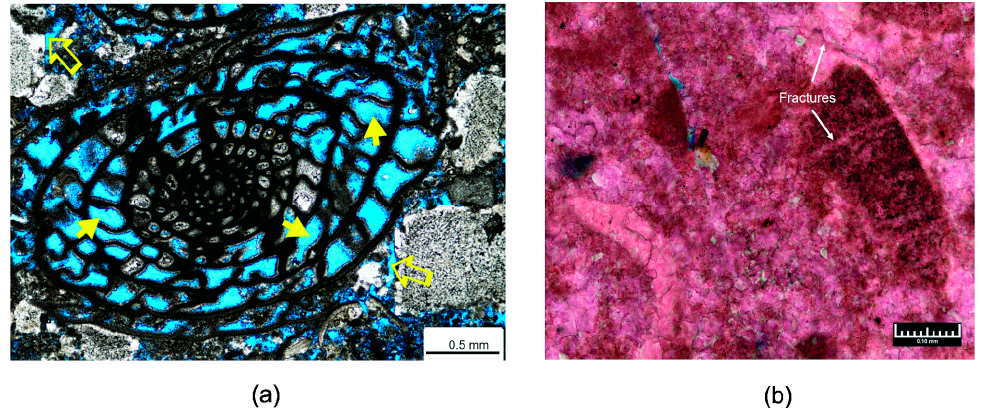
Figure 22. Comparison of photomicrograph from ( a ) well 9 with that from ( b ) well 6. Note: in ( a ) lots of intergranular pores but in ( b ), no pore spaces exist and all fractures are resealed by calcite (Figure 22a courtesy Fu and Ambrose, 2020, reproduced with permission of GCAGS).